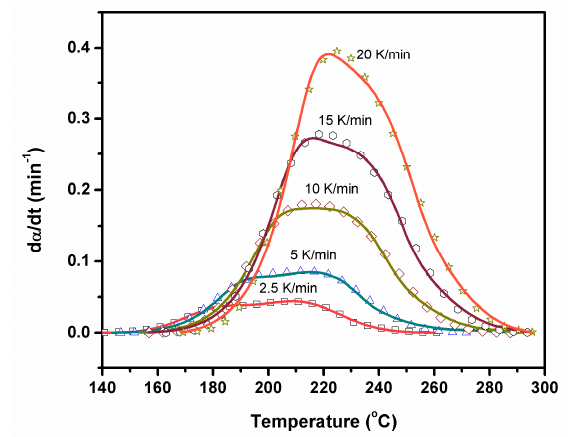
Figure 6. Normalized y(a), z(a) versus ( α ) plots for P-ddm/APbPc system, reaction 1 ( A ) and reaction 2 ( B ).